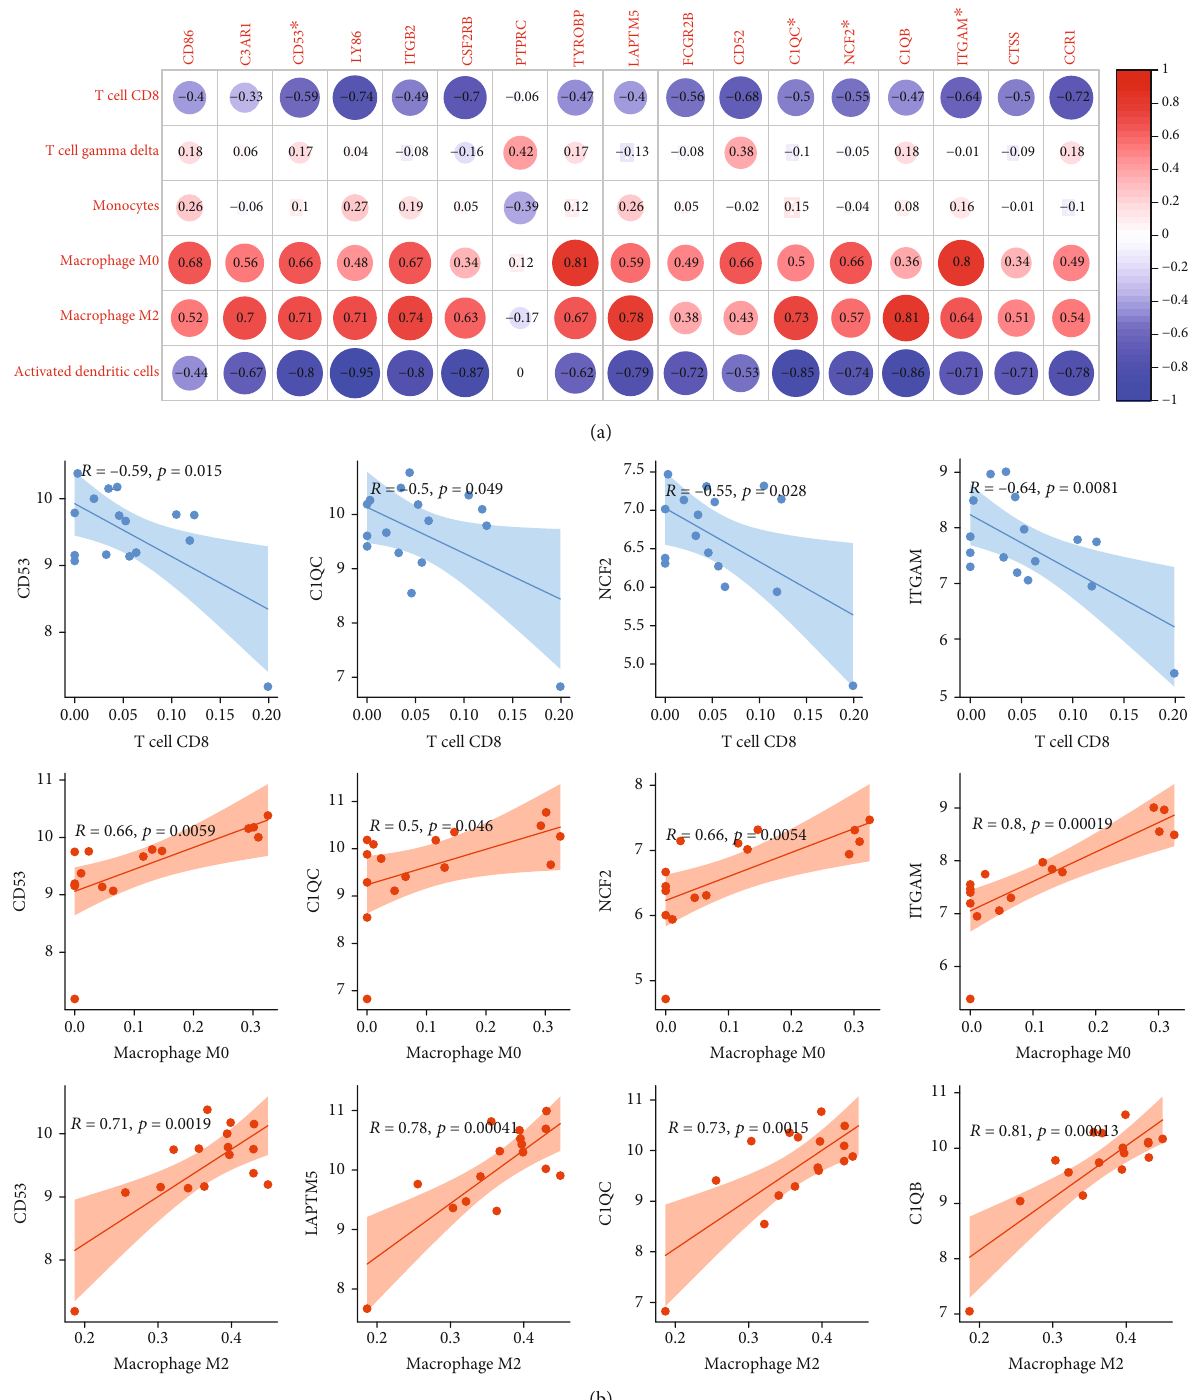
Figure 5: (a) Correlation between gene expressions and the relative percentages of immune cells in the AA group. (b) Scatterplots illustrate the relationship between four common gene expressions ( CD53 , C1QC , NCF2 , and ITGAM ) and the relative proportions of these three types of immune cells (T cell CD8, macrophage M0, and macrophage M2). Gray-shaded areas in scatterplots represent the standard errors of the regression lines. R : correlation coe ffi cient. ∗ Icon indicates the four common